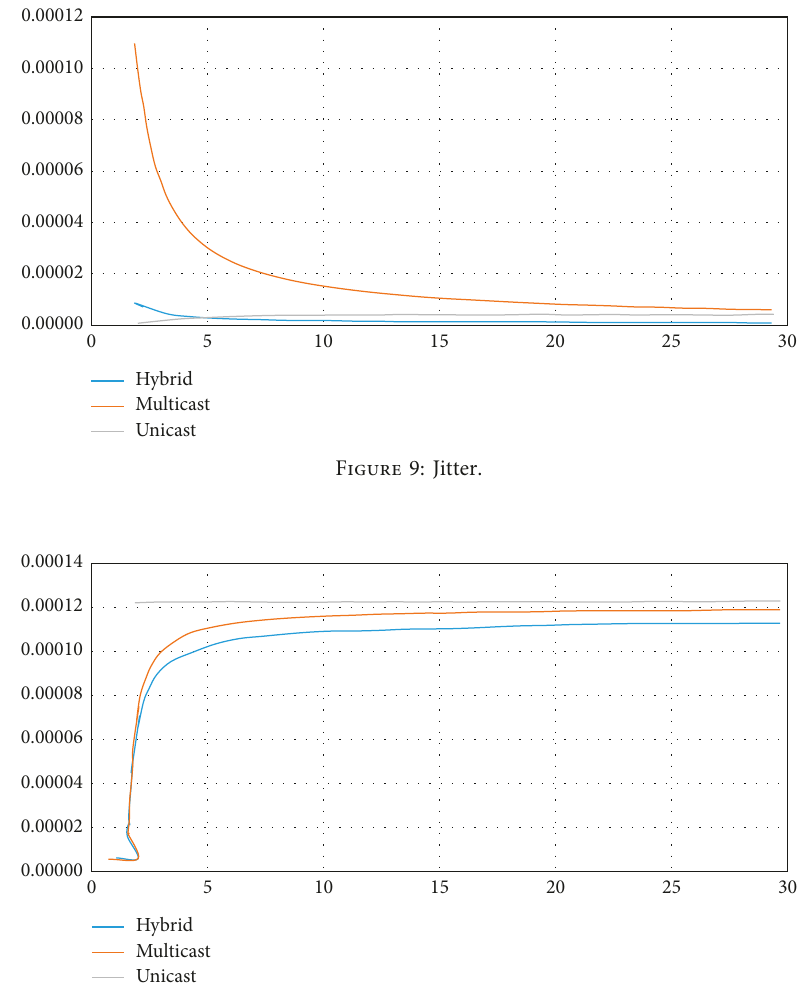
Figure 10: Queuing